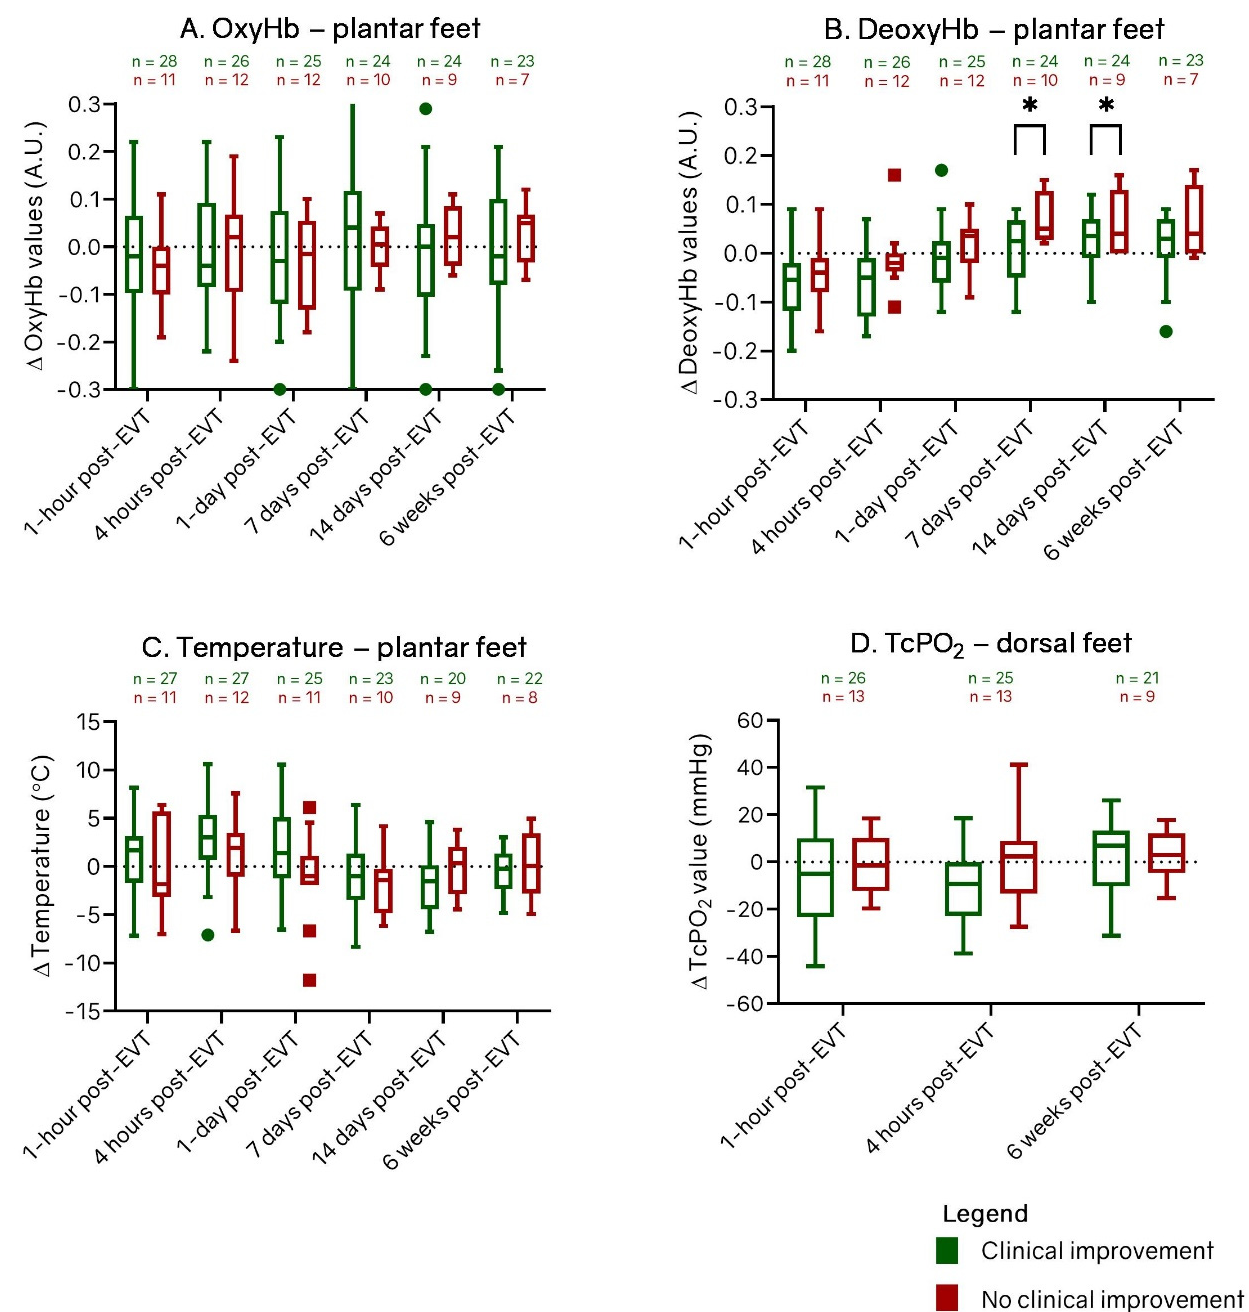
Figure 4. Box-and-whisker plots of change between patients with and without clinical improvement in ( A ) oxyhemoglobin (OxyHb), ( B ) deoxyhemoglobin (DeoxyHb), and ( C ) temperature values at the plantar side and ( D ) change in transcutaneous oxygen pressure (TcP O 2 ) values at the dorsal side of all treated feet after endovascular therapy (EVT). Groups are divided in limbs with (green) and without (red) clinical improvement at 6 weeks. The horizontal line in the middle of each box indicates the median; the top and bottom borders of the box mark the 75th and 25th percentiles, respectively, and the whiskers mark the highest value and lowest value within 1.5 × IQR of the 75th and 25th percentiles. The dots are outliers of patients with clinical improvement and the squares are outliers of patients without clinical improvement. A.U.: arbitrary units. * p < 0.05.